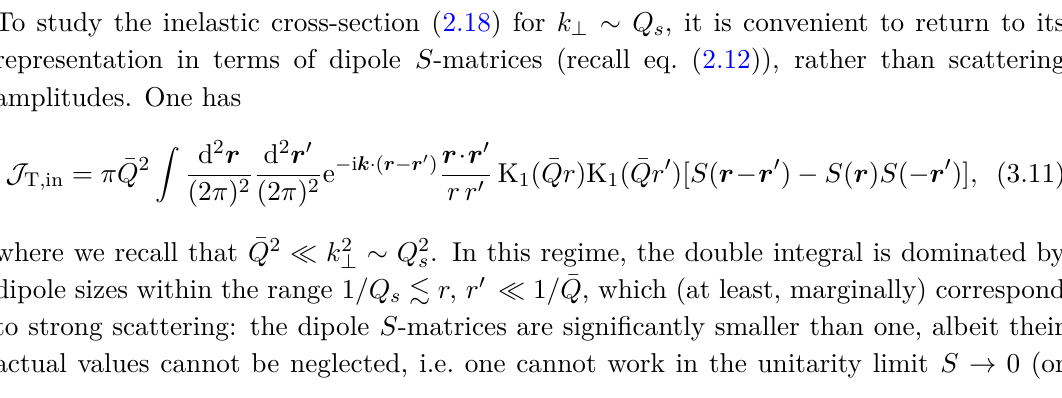
Figure 4. (a) Rapidity evolution of the transverse elastic cross-section multiplied by k 2 Q 2 = 2 GeV 2 , for 3 different values for ¯ Q 2 and 4 different rapidities ( η = 0 , 1 , 2 , 3 ); see the s 0 main text for details. (b) Rapidity evolution of the transverse elastic and inelastic cross-sections multiplied by k 2 , for fixed ¯ Q 2 = 0 . 1 GeV 2 and the same 4 values for η ⊥